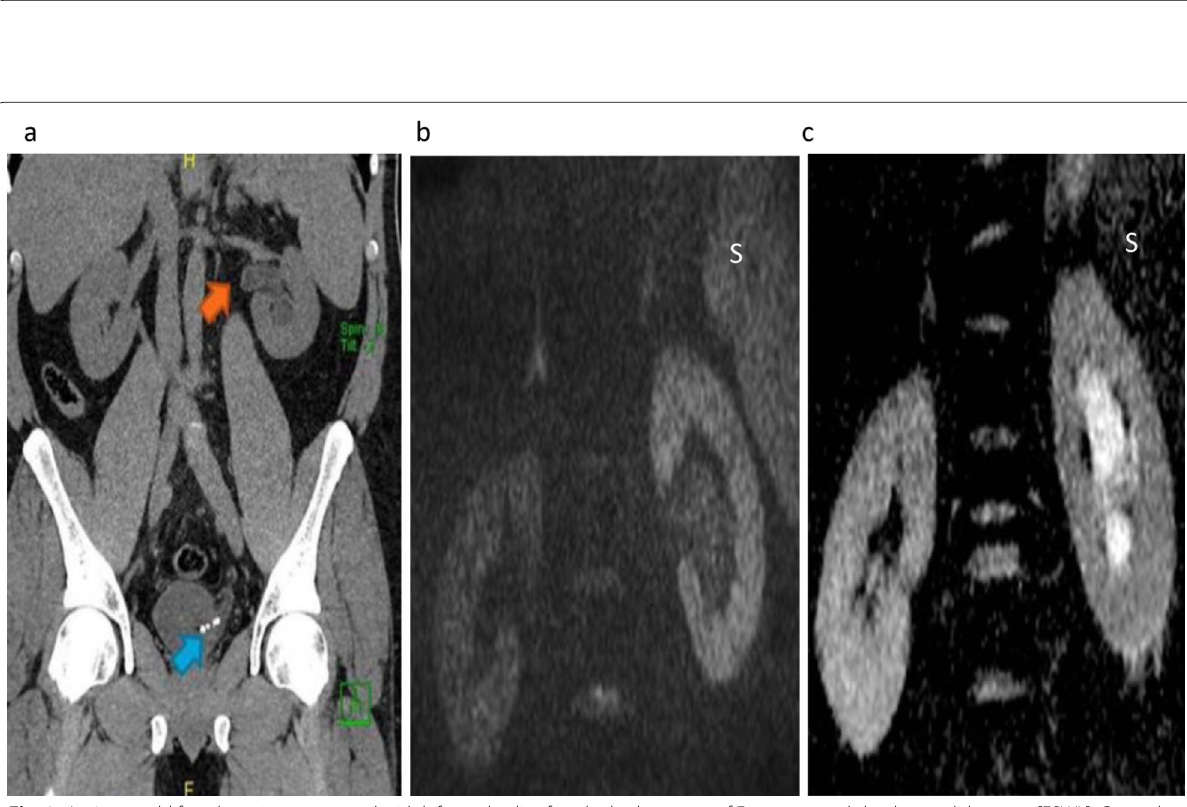
Fig. 3 A 42-year-old female patient presented with left renal colic after she had two sets of Extracorporeal shock wave lithotripsy [ESWL], Coronal reformatted CT ( a ), showed left hydronephrosis [orange arrow] and multiple small stones [blue arrow] at left ureterovesical junction. Diffusion image ( b ) demonstrated diffuse high signal of the left kidney compared with contralateral right kidney. ADC map ( c ), Showed a reduction of the signal intensity of the left kidney with hydronephrosis compared with the right kidney and spleen. S refers to spleen at both ( b , c